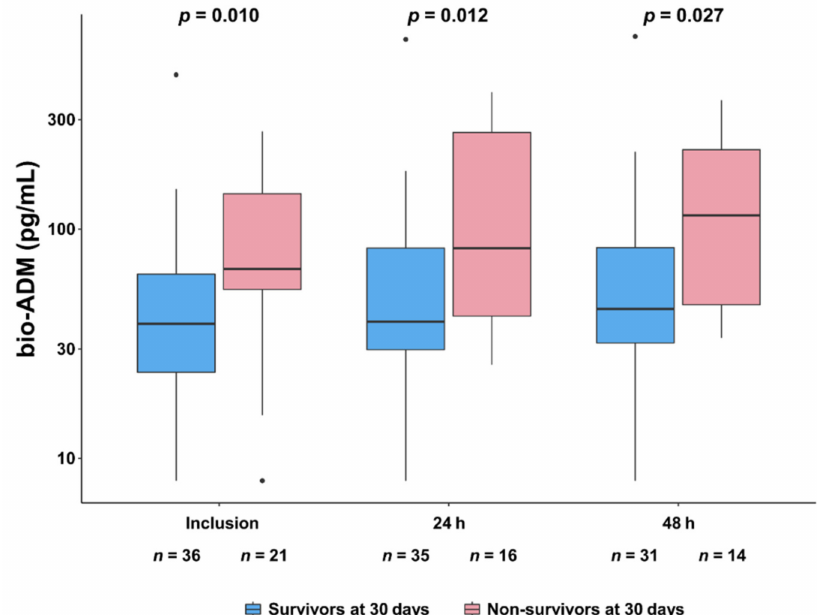
Figure 1. Comparison of time-course of bio-ADM, from inclusion to 48 h, between 30-day survivors and non-survivors. A base-10 log scale is used for the y-axis. Dots indicate outliers. Comparisons at each time point were performed using the Kruskal–Wallis test comparing bio-ADM values in 30-day survivors vs. 30-day